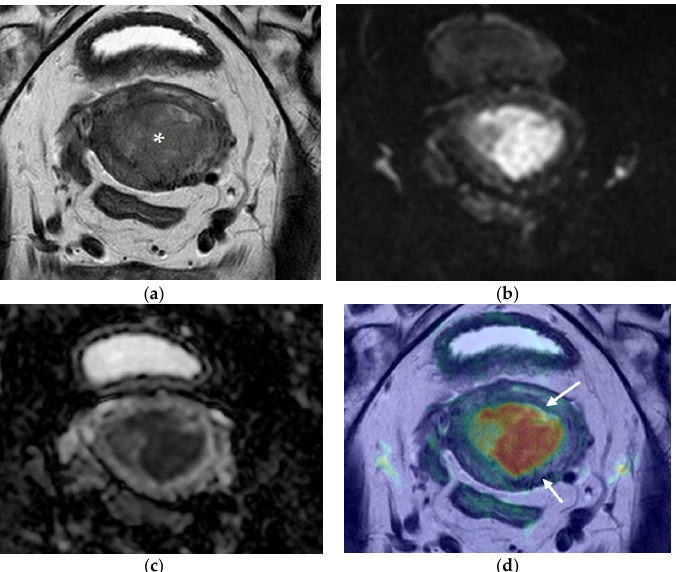
Figure 2. Pelvic MRI. Axial oblique sequences oriented to the corpus uteri long axis: ( a ) T2WI; ( b ) DWI (b1000); ( c ) ADC map; ( d ) fused T2WI-DWI image. Endometrial cancer is perceptible in ( a ) as a polypoid lesion with posterior implantation base (asterisk). When interpreting the morphologic ( a ) and functional images ( b , c ), deep myometrial invasion is questionable, but clearly excluded in fused images ( d ), where clear demarcation of the endometrial cancer and external myometrium is evident (arrows).